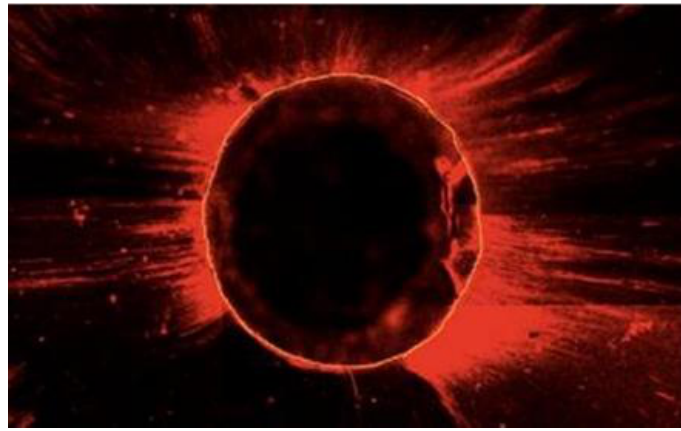
Figure 1. Image of the root canal section, where the circumference area was measured by Image J ® .